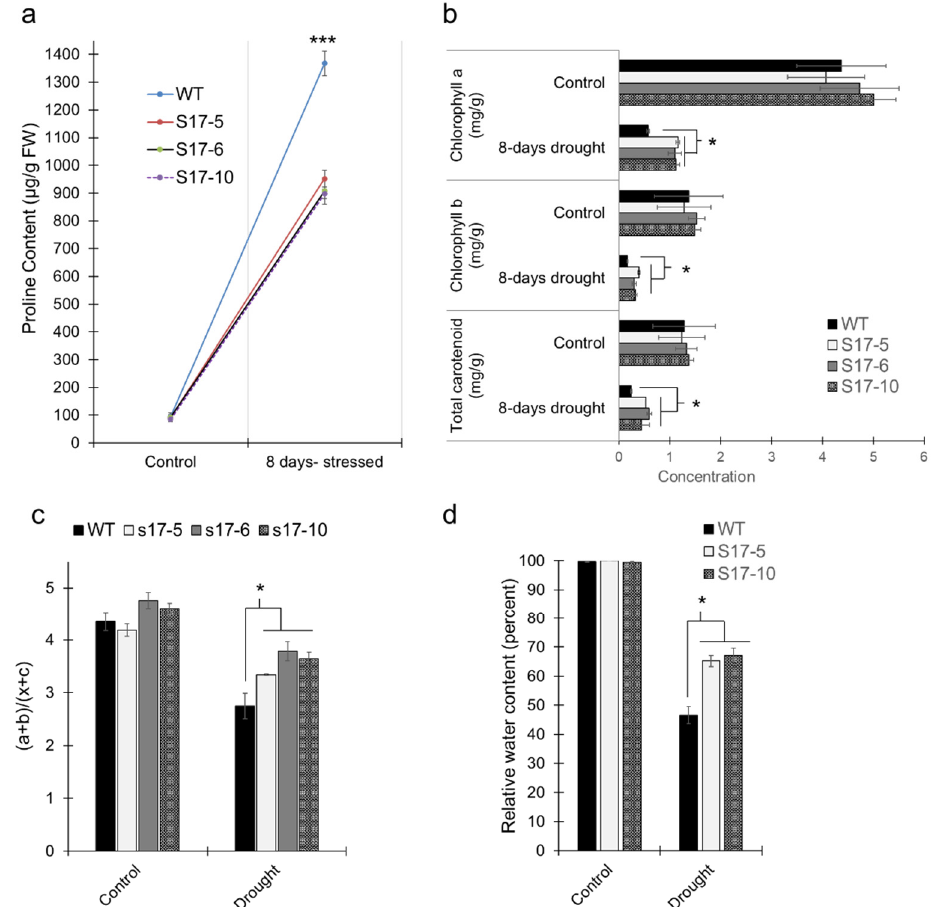
Figure 3. AtGRXS17 -expressing maize plants were less stressed than WT plants under drought stress. ( a ) Proline accumulation of WT and AtGRXS17 -expressing maize plants under control (well-watered) and drought stress after 8 days; ( b ) Total chlorophyll and carotenoid content in the WT and AtGRXS17 -expressing maize plants under control (well-watered) and drought stress after 8 days; ( c ) Graph represents the stress as measured by the ratio of total chlorophyll to total carotenoids; ( d ) Relative water content of 4-week-old WT and two AtGRXS17 -expressing maize seedlings under control (well-watered) and drought stress after 5 days. Data shown are Mean ± SE ( n = 6) and were analyzed using one-way ANOVA. Asterisks indicate significance level (* p < 0.05, *** p < 0.001). Stomatal conductance of both AtGRXS17 -expressing and WT plants gradually de- creased as drought stress was imposed. Stomatal conductance remained similar for both the transgenic and WT lines on day 1 and day 5 of drought treatments but decreased in WT plants on day 8, while remaining steady in AtGRXS17 -expressing plants (Figure 4a). Chlorophyll fluorescence, as measured by Fv/Fm ratio, gradually decreased under drought treatment. No difference in the chlorophyll fluorescence was observed on ear leaf